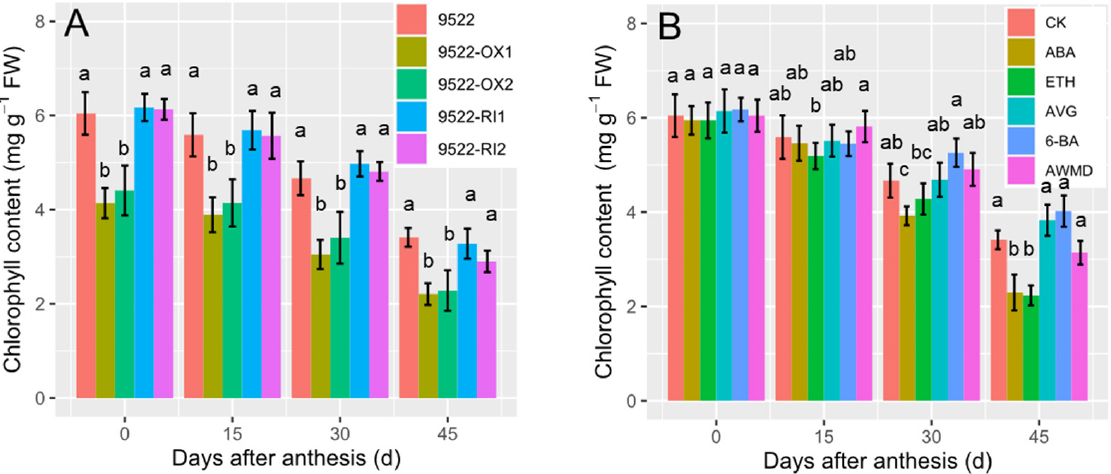
Figure 1. Changes in chlorophyll contents of flag leaves of wildtype and transgenic lines ( A ), and application of exogenous phytohormone/alternate wetting and under moderate drying (AWMD) irrigation ( B ) during grain filling (0–45 days after anthesis). 9522-OX1 and 9522-OX2, two transgenic lines with overexpression of NYC3 (Non-Yellow Coloring 3) in variety 9522; 9522-RI1 and 9522-RI2, two RNA interference transgenic lines in variety 9522; ABA, exogenous application of abscisic acid; ETH, exogenous application of ethephon (an ethylene-releasing agent); AVG, exogenous application of aminoethoxyvinylglycine (an inhibitor of ethylene synthesis by inhibiting 1-aminocylopropane-1- carboxylic acid synthesis); 6-BA, exogenous application of benzylaminopurine (a synthetic cytokinin). Different letters above columns indicate statistical significance at the p < 0.05 level between different genetic lines/treatments of each plant organ. Values are the means ± SD.